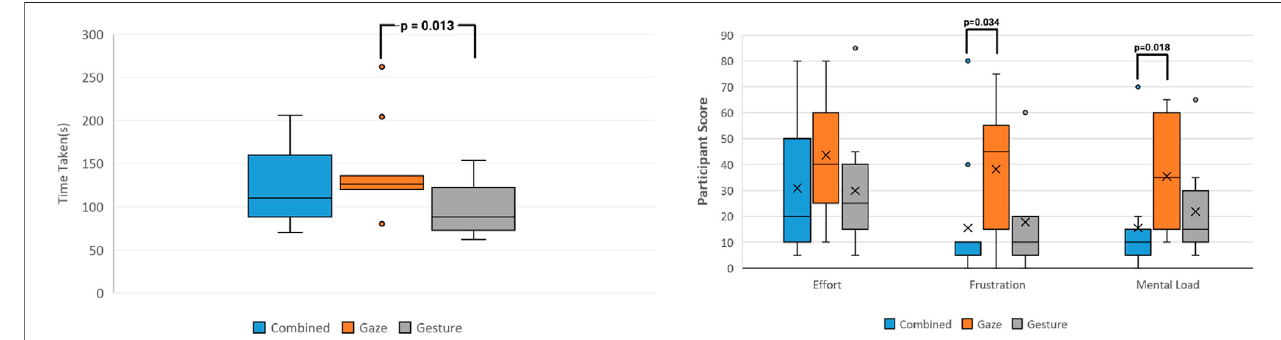
TABLE 2 | Summary of User study 2.